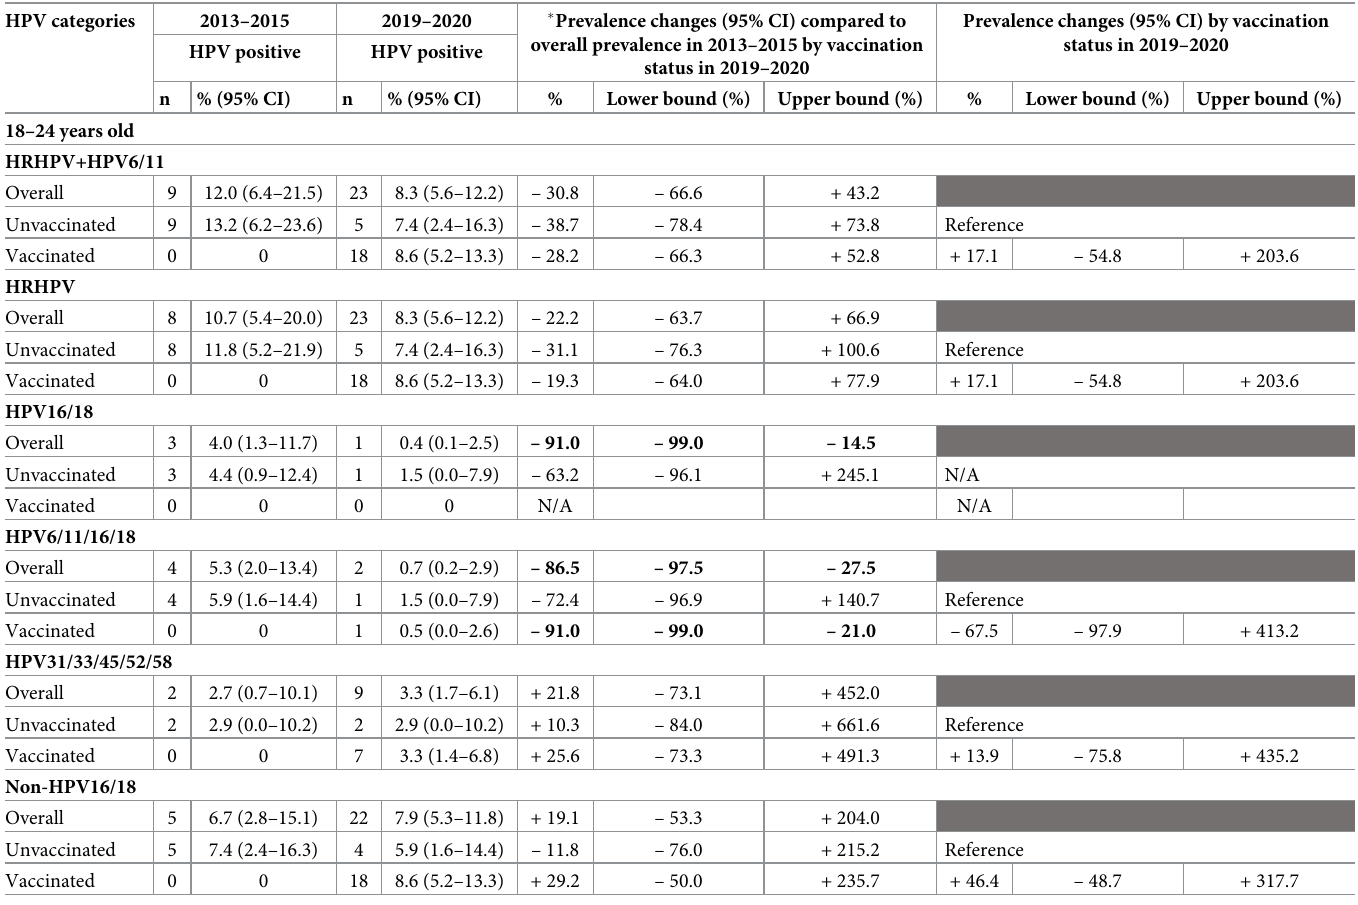
Table 3. HPV prevalence among women aged 18–24 by vaccination status and study